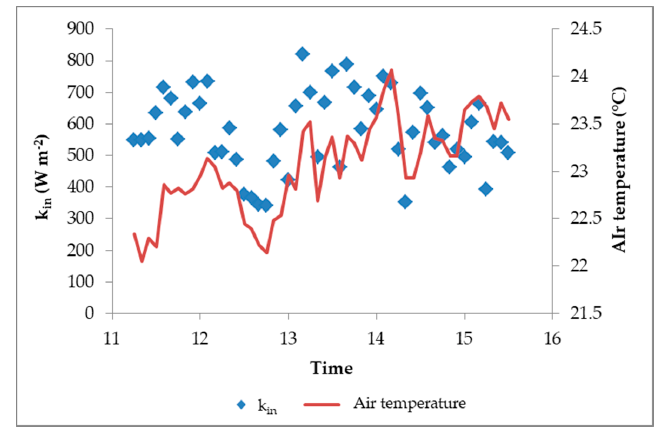
Figure 5. Air temperature and k in for the reference site on DOY (day of year) 262. Data points are shown for times when data was